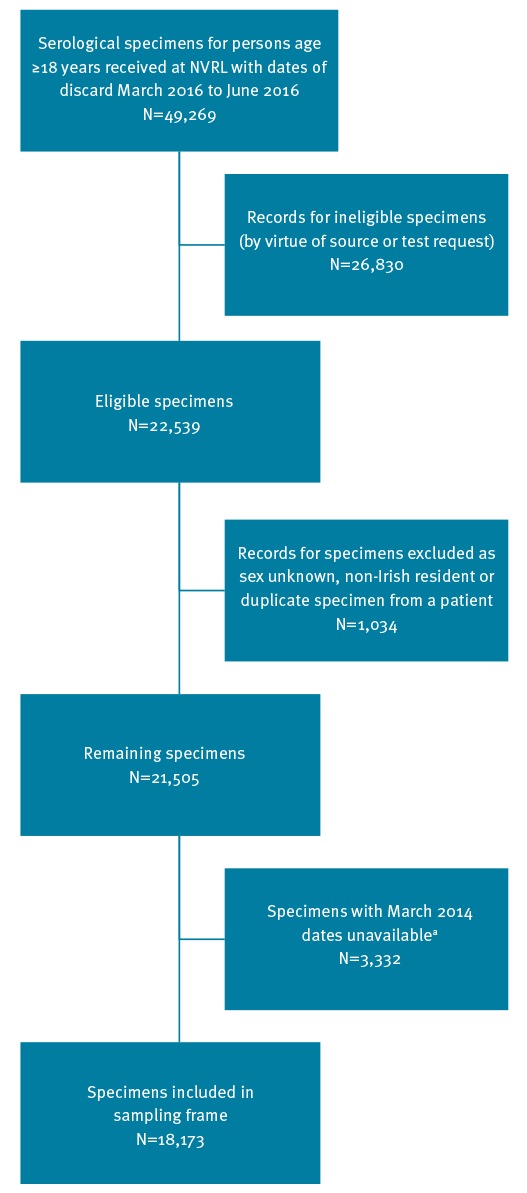
Construction of hepatitis C virus study sampling frame, Ireland, 2014–2016